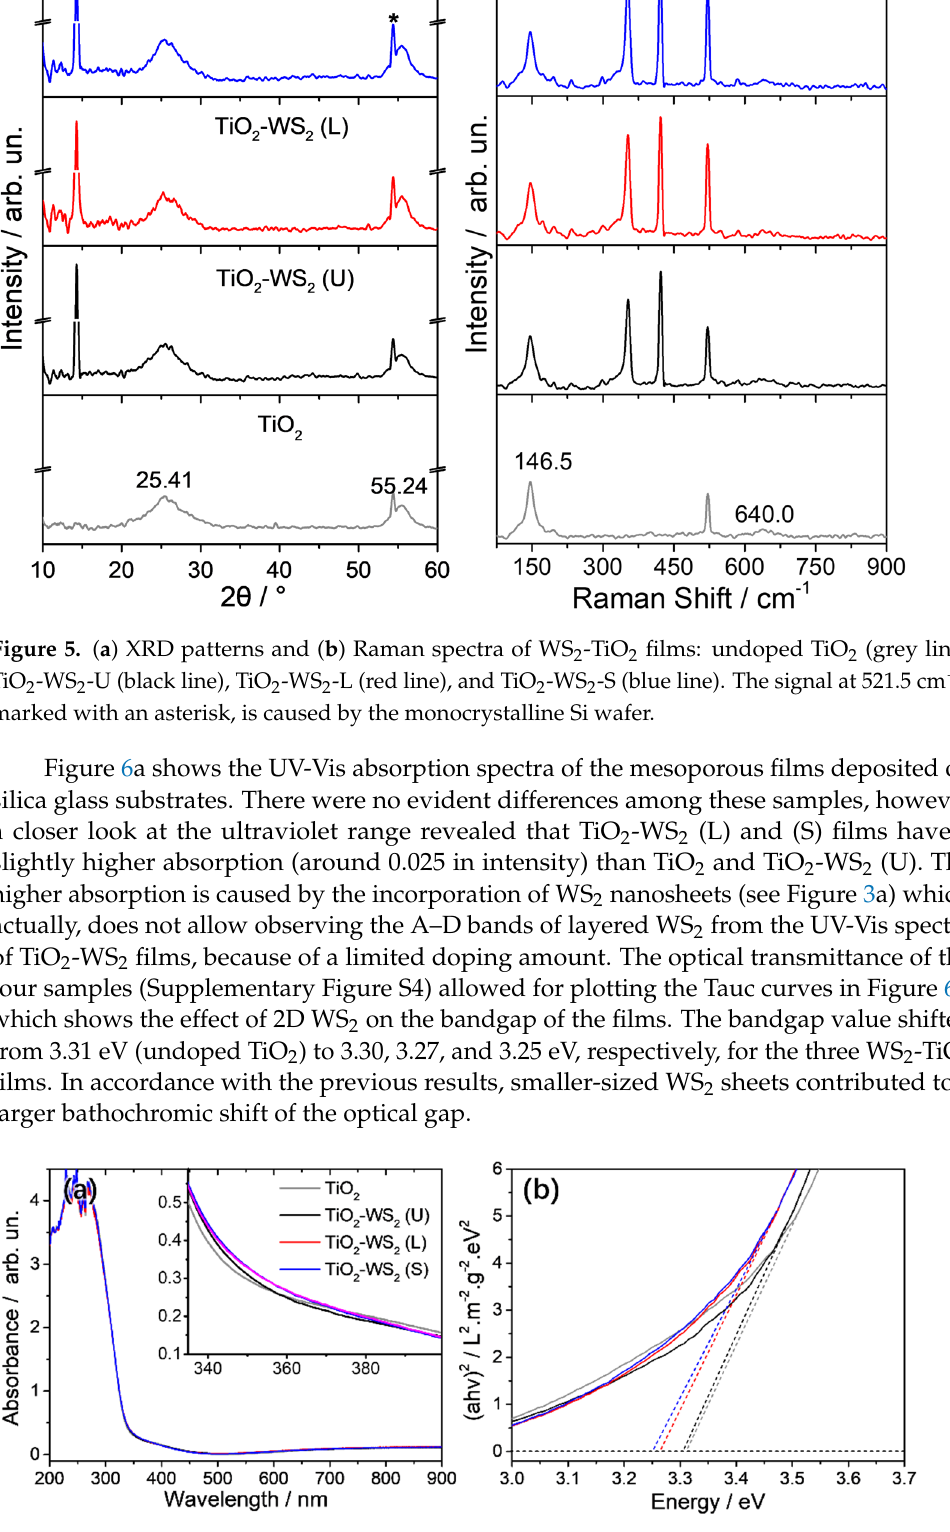
Figure 6. ( a ) UV-Vis absorption spectra and ( b ) Tauc plots of WS 2 -TiO 2 films: undoped TiO 2 (grey line), TiO 2 -WS 2 -U (black line), TiO 2 -WS 2 -L (red line), and TiO 2 -WS 2 -S (blue line). The inset in ( a ) shows an enlarged region in the 330–400 nm region.